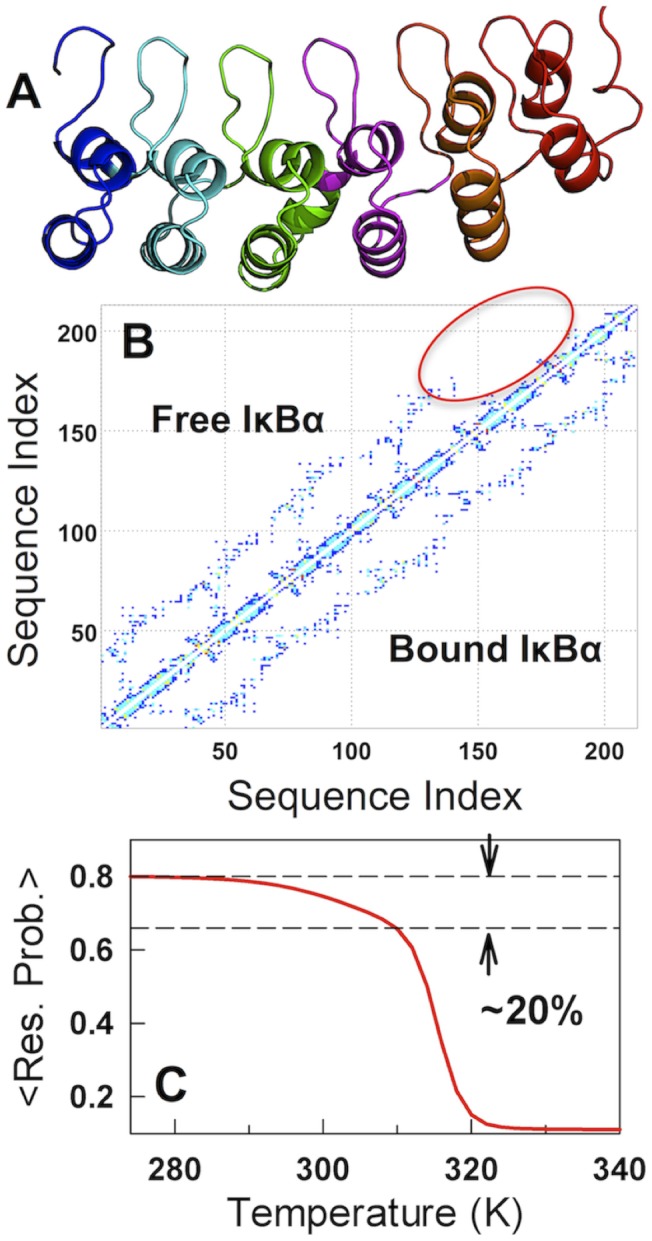
Modeling disorder in IκBα and thermodynamics.(A) Crystal structure of the bound-IκBα. (B) Contact-map of bound- and modeled free-IκBα. It can be seen that the repeats 5 and 6 in the modeled free-IκBα (circled region) are dominated by local contacts. (C) The predicted unfolding curve for the free-IκBα with a prominent pre-transition that accounts for ∼20% of the total unfolding amplitude.